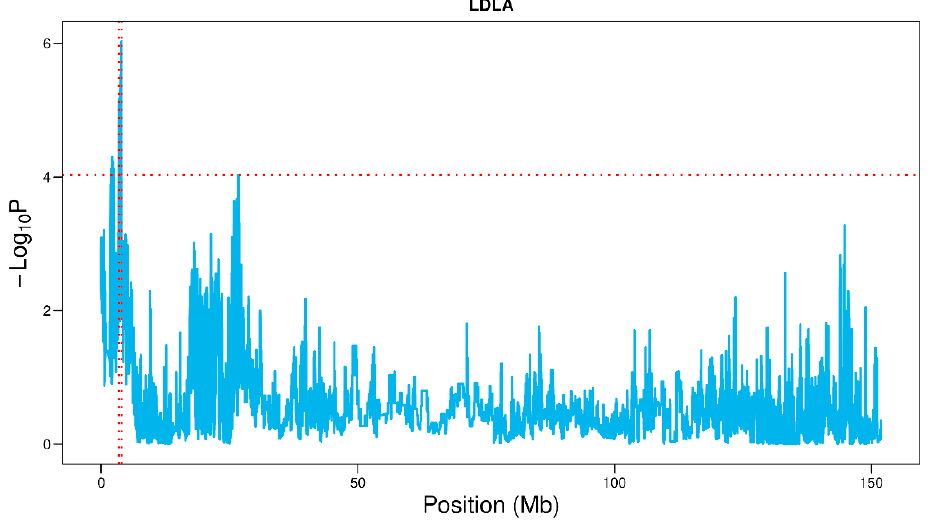
Figure 2. Confidence interval on SSC2 in LDLA of VL of Suhuai pigs. The two red vertical lines represent the range of the confidence interval identified by LDLA. The red horizontal line represents the threshold of LDLA.